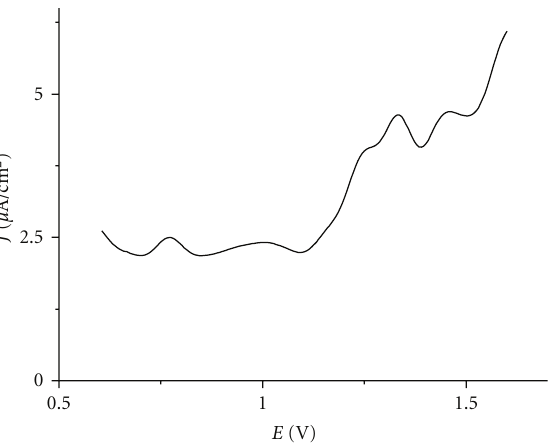
Figure 7: Residual current in indi ff erent electrolyte solution.